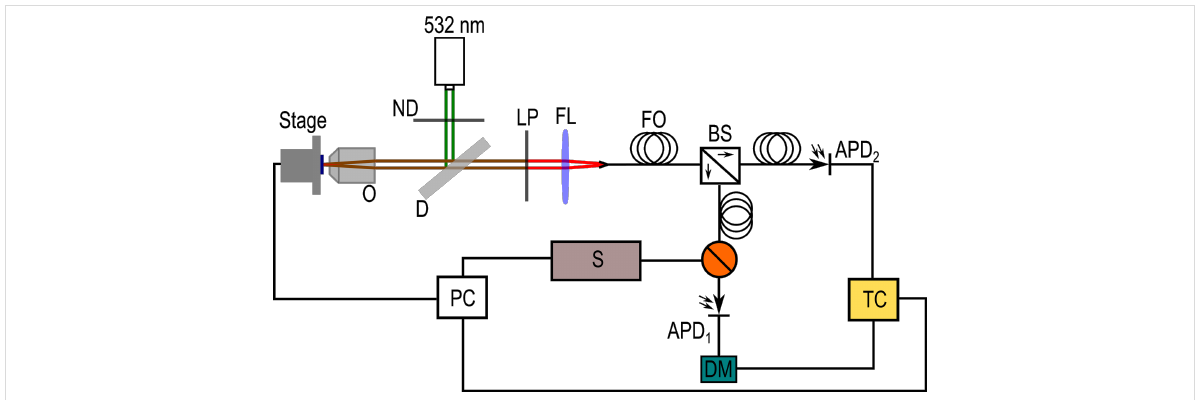
Figure 1: The experimental setup of the scanning confocal microscope used for investigating TiO 2